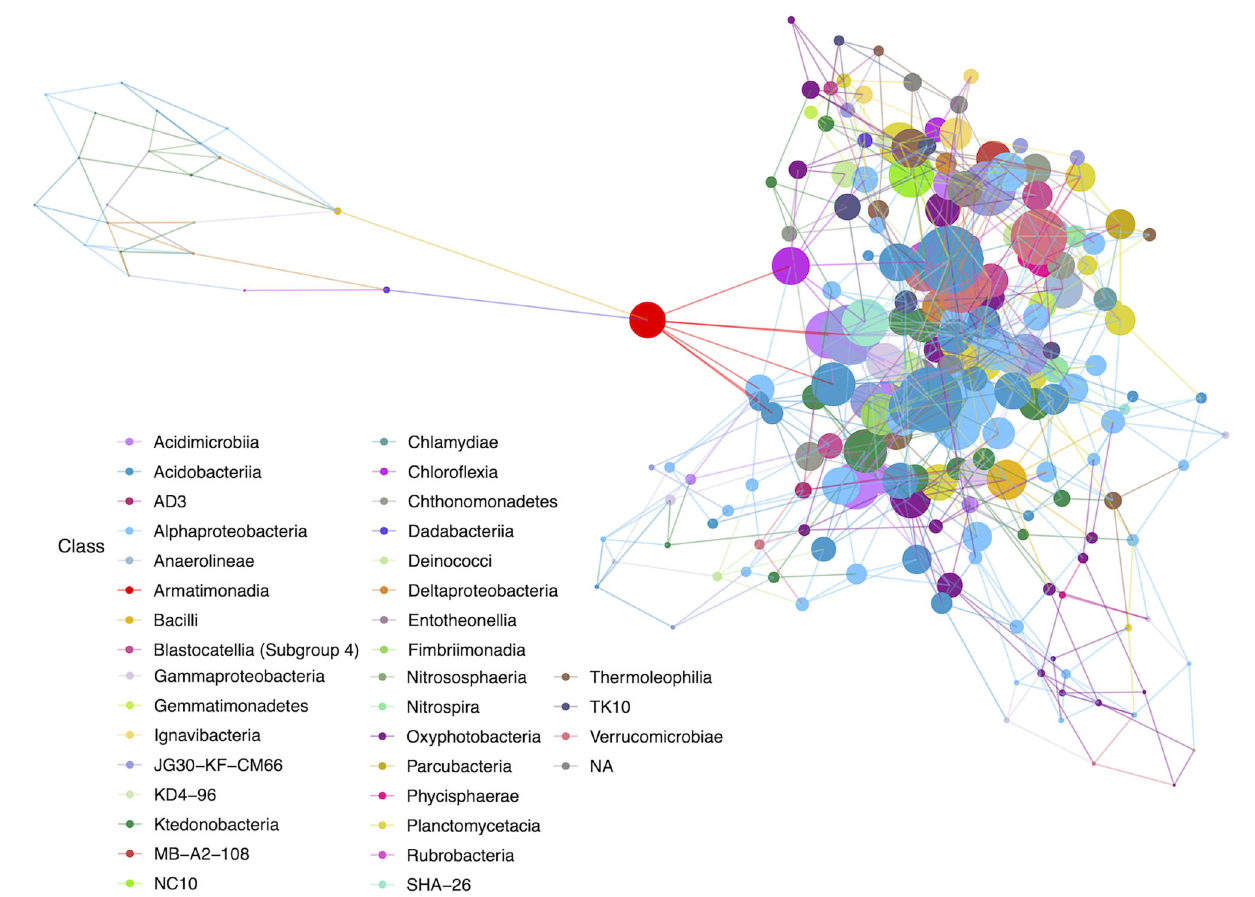
FIGURE 6 | Hub network for geothermal sites, illustrating a high level of complexity within the network. There are 100 nodes that have an above-average hub score (represented by larger circles in the network). Hubs are taxa that most likely have important ecological roles, such as keystone species, and help maintain the overall network structure.